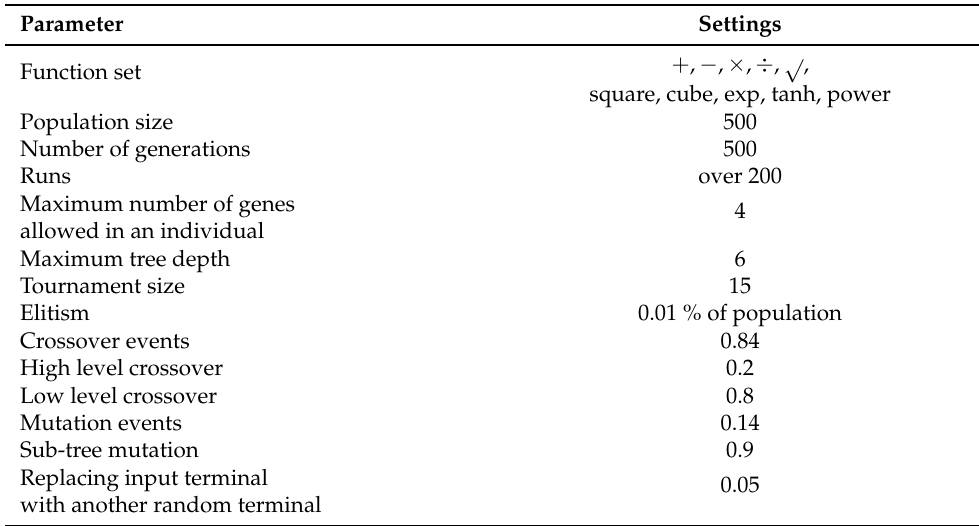
Table 2. MGGP parameter